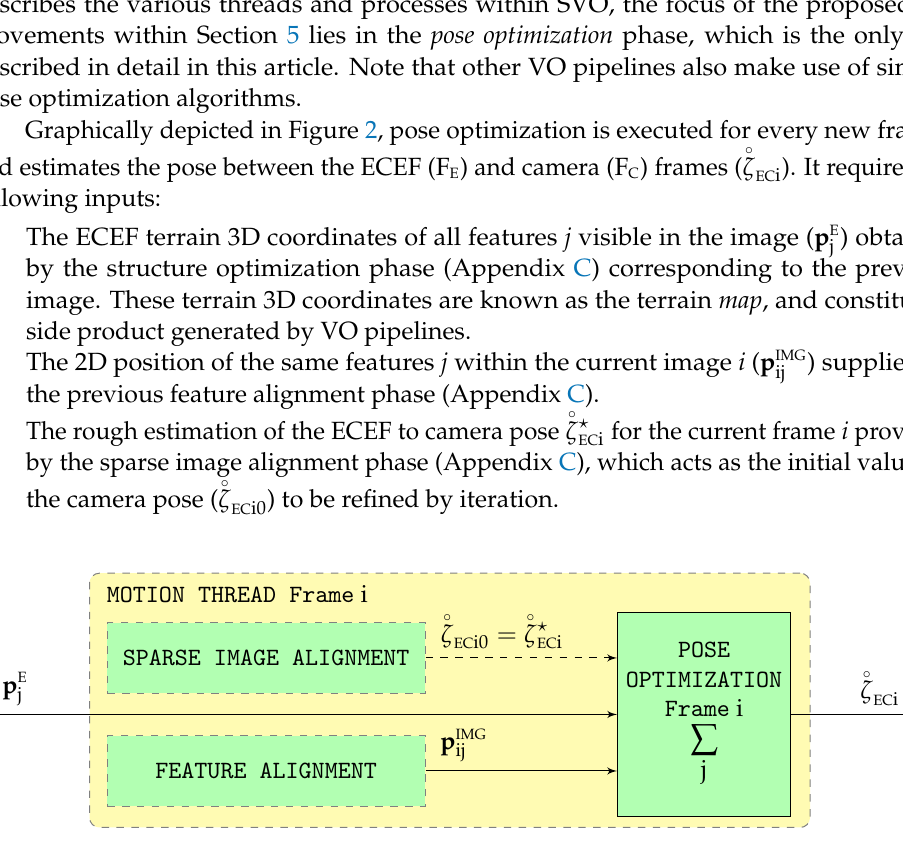
Figure 2. Pose optimization flow diagram.